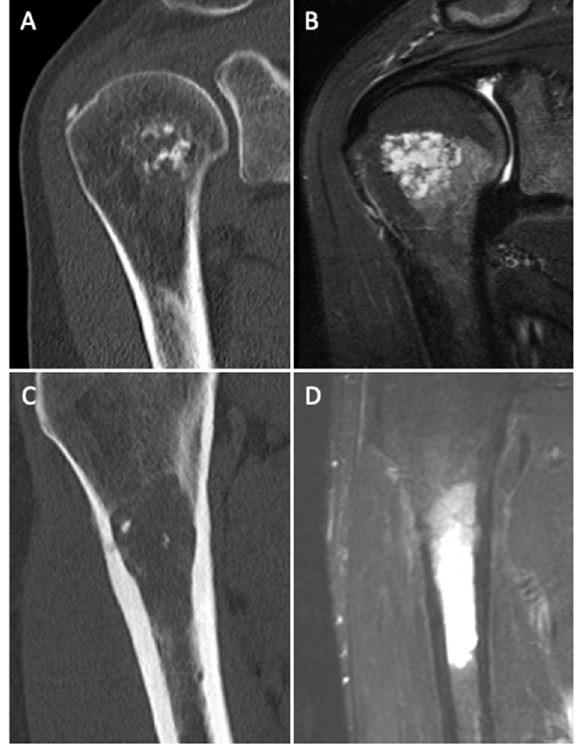
Figure 2. Exemplary computed tomography ( A , C ) and magnetic resonance images (short-tau inver- sion recovery (STIR) image) ( B , D ) of an enchondroma in the coronal plane ( A , B ) showing a lobulated tumor architecture without endosteal scalloping and an ACT in the sagittal plane showing endosteal scalloping and edema within the bone ( C , D ).